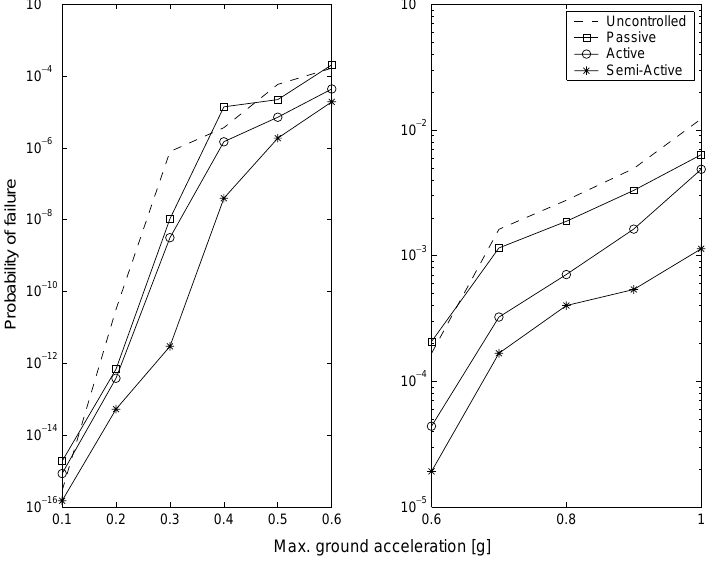
Fig. 8. Fragility curves of the rail for different control